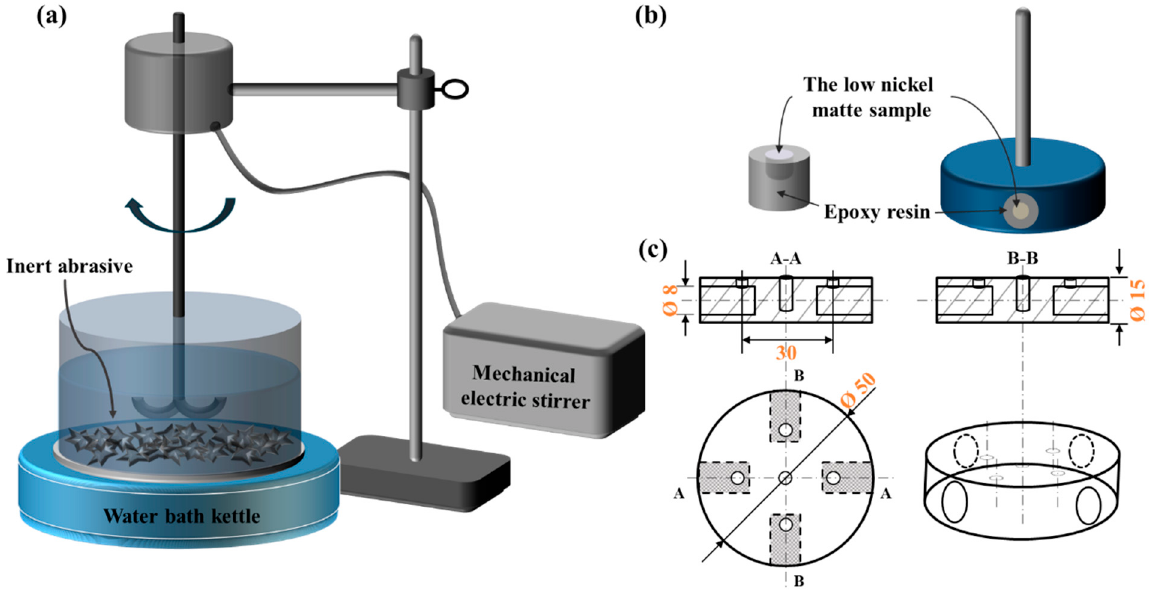
Figure 1. ( a ) The schematic diagram of the experimental setup; ( b ) the schematic diagram of the low-nickel matte sample setup; ( c ) the schematic diagram of the rotating cylinder. Table 1. Values of rotational speed and relative speed.